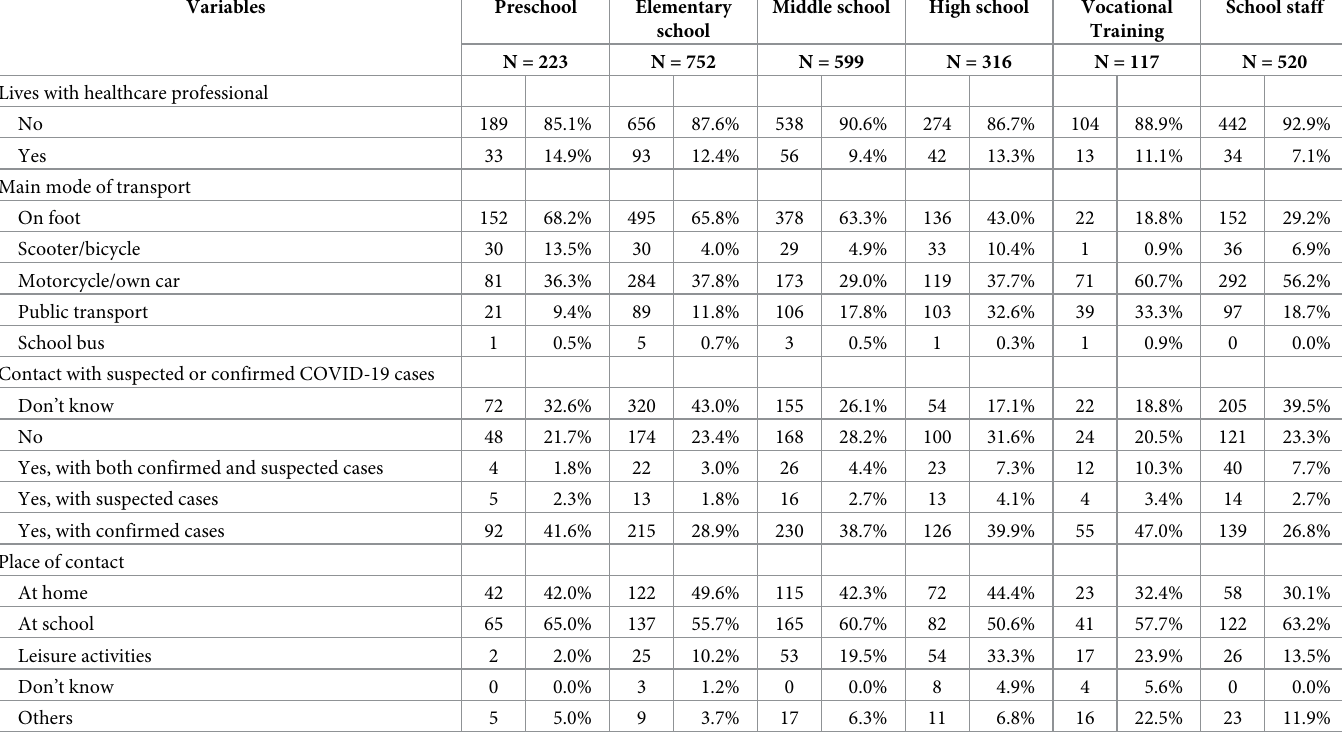
Table 4. Contact pattern of students and school staff participating in the sentinel school project, Catalonia, Spain. February-March 2021.